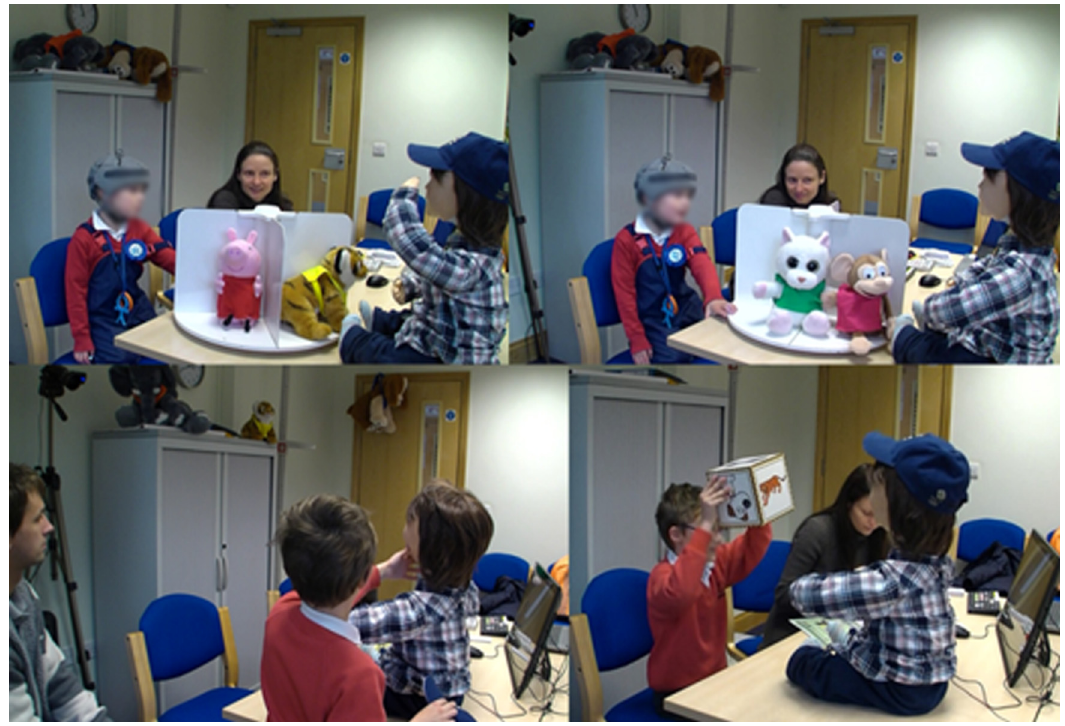
Figure 5: Children participating in the study with